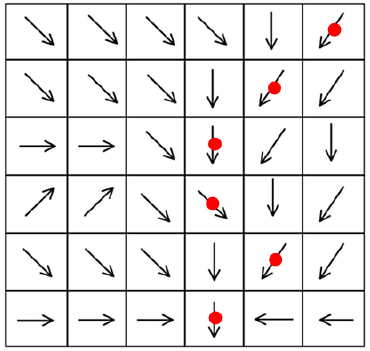
Figure 3. The path of water flow determined by the flow directions.